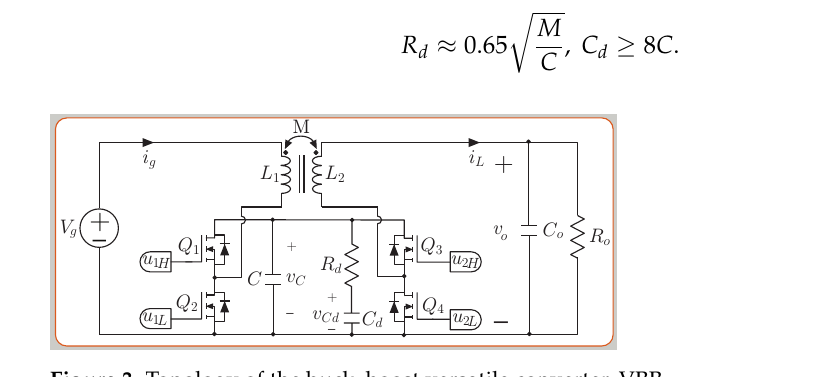
Figure 3. Topology of the buck–boost versatile converter, VBB. Table 2. Selected components and parameters of the versatile buck-boost